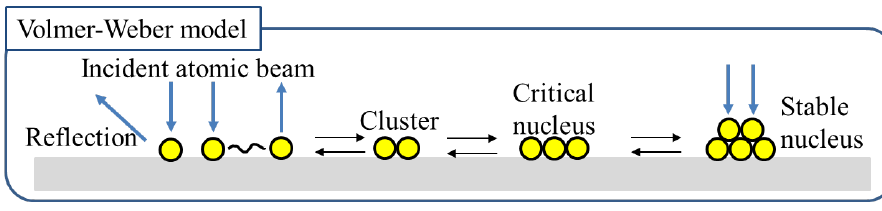
Figure 5. Formation of a nucleus in the Volmer–Weber model.